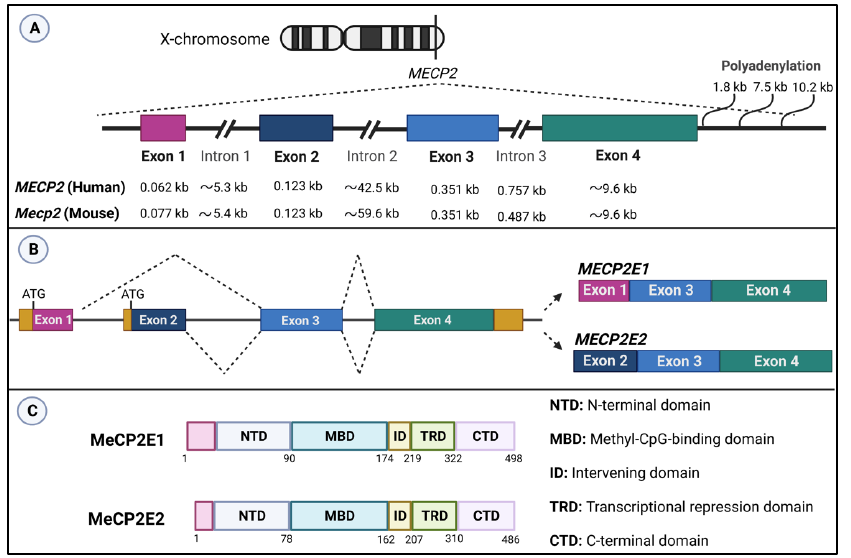
Figure 1. Schematic diagram of ( A ) MECP2/Mecp2 gene, ( B ) MECP2E1 and MECP2E2 transcripts, ( C ) MeCP2E1 and MeCP2E2 isoforms. MeCP2: methyl-CpG binding protein 2. The dark yellow boxes show 5 (cid:48) and 3 (cid:48) untranslated regions (UTR). The drawing is not to scale. Information obtained from [12,74,75,77]. Figure is created with